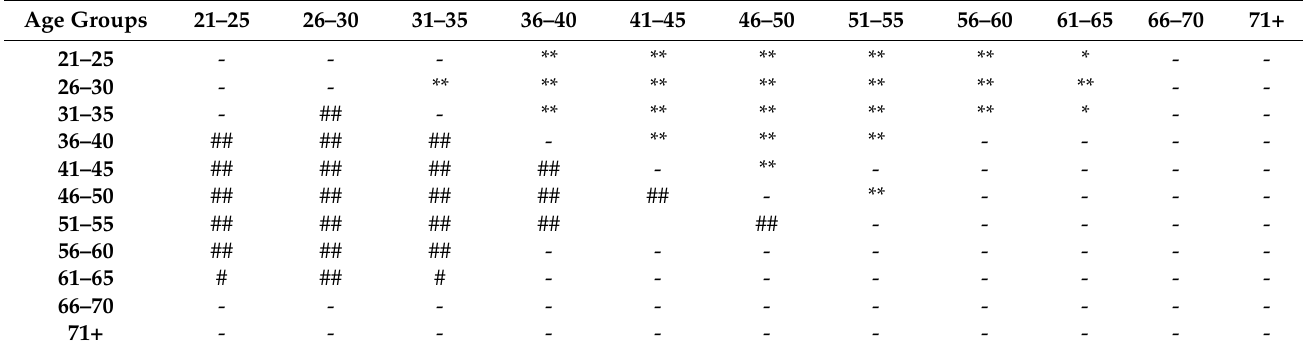
Table 2. Bonferroni post hoc tests of age